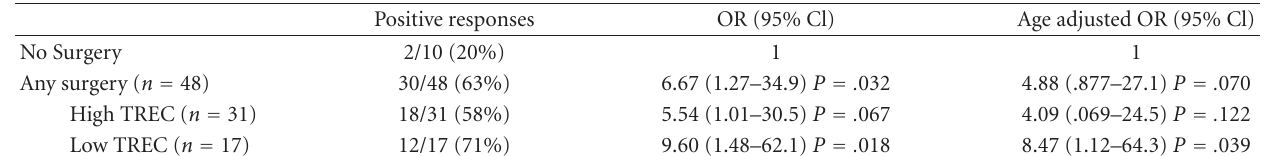
Table 2: Symptoms reported by subjects with CHD.